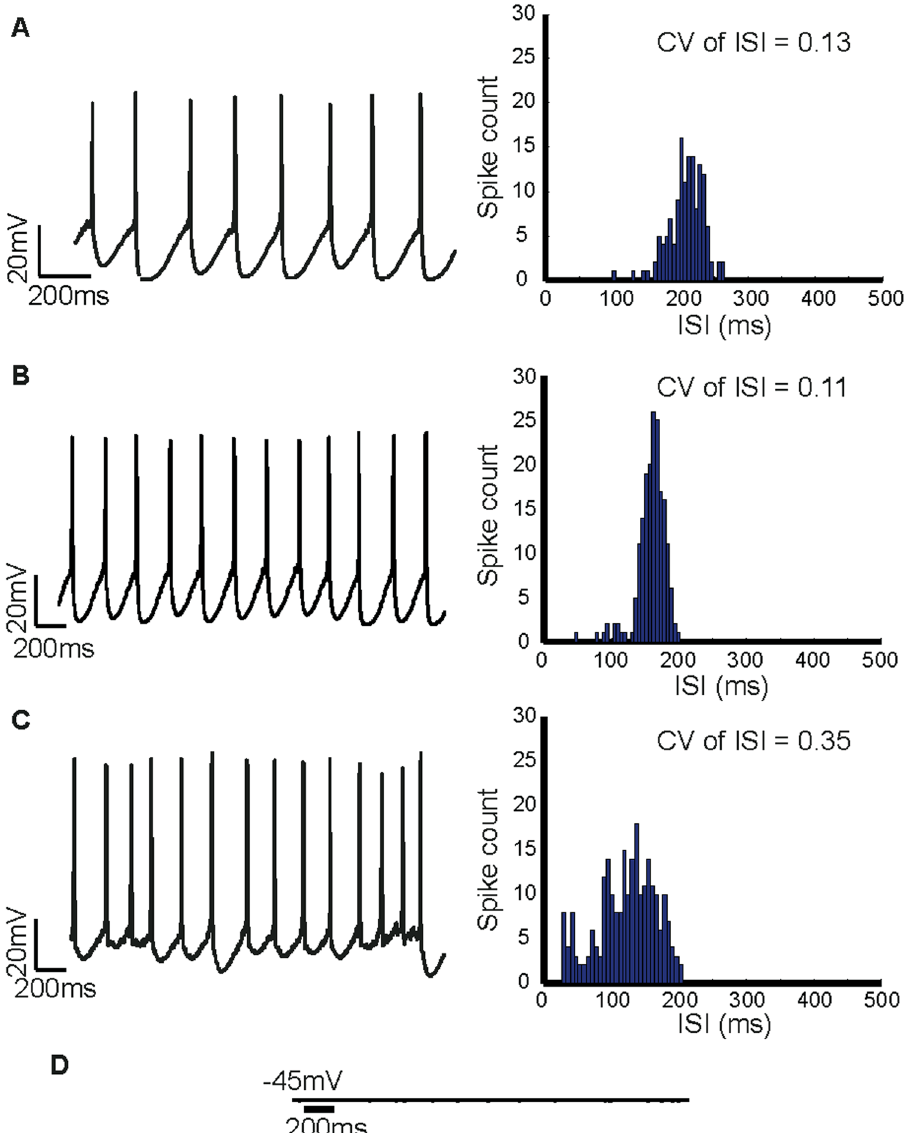
Figure 3. Effects of simulated inhibition of ion channels regulating spontaneous firing in the model dopamine neuron. ( A ) Under control conditions the in silico neuron fired spontaneously at a rate of 3.6 Hz ( left ). ( B ) When the maximal conductance of A-type potassium channels is reduced by 50% from 4 mS/cm 2 to 2 mS/cm 2 we observed a 1.8% increase in firing rate. As we can see from the ISI histogram, there was no change in the CV of ISI, indicating that A-type channels are involved in regulating firing rate and not firing regularity. ( C ) When the L-type calcium channel was inhibited by reducing the maximal conductance from 15 mS/cm 2 to 5 mS/cm 2 there was a marked decrease in firing regularity as can be seen from the spike train ( left ) and the ISI histogram. The CV of ISI increased from 0.13 to 0.35, which is a similar increase observed during SK channel inhibition. ( D ) Simulating a sodium channel block resulted in a cessation of firing indicating that sodium channels are essential for spike